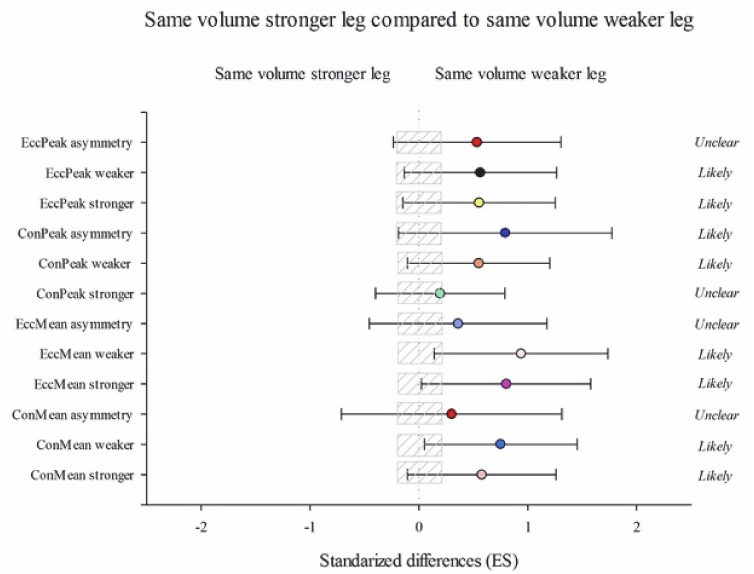
Figure 4. Efficiency of the unilateral eccentric overload training performing the same volume with both leg starting with the stronger leg (SVS) compared with the unilateral eccentric overload training performing the same volume with both legs starting with the weaker leg (SVW). Training program to improve a lateral squat in mean concentric power (ConMean) with the stronger and the weaker